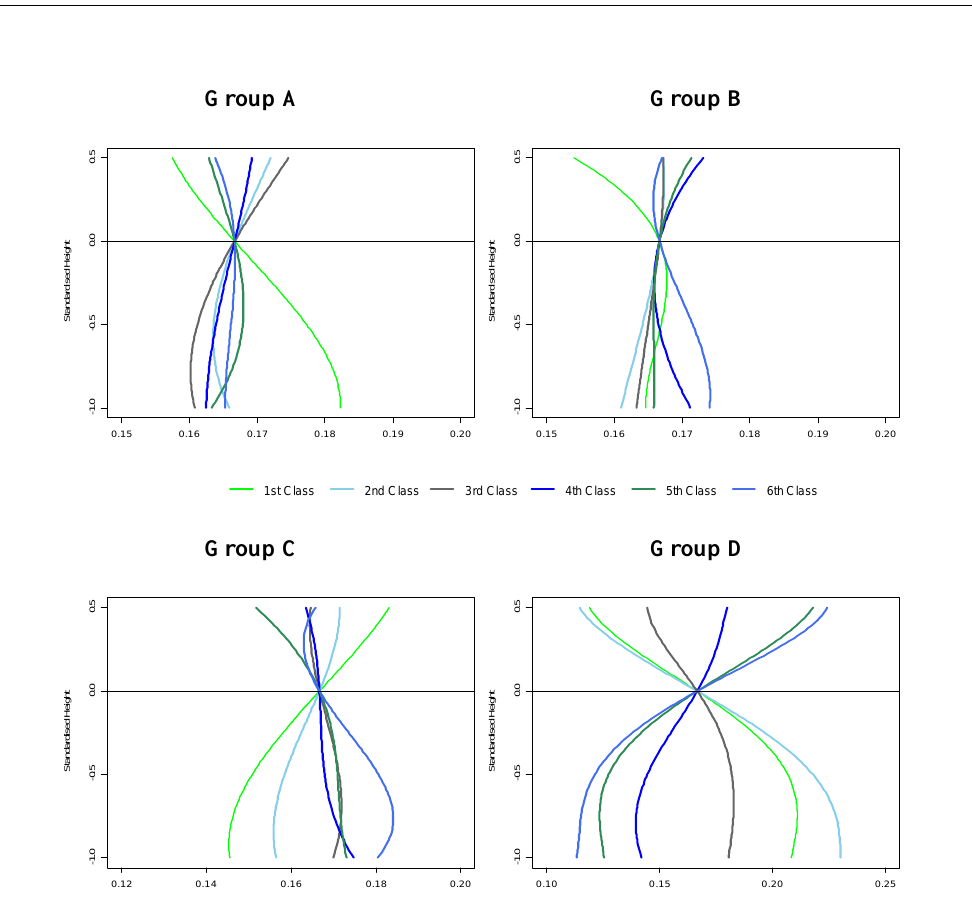
Fig. 11. Typical centred vertical profiles estimated using the statistical hierarchical